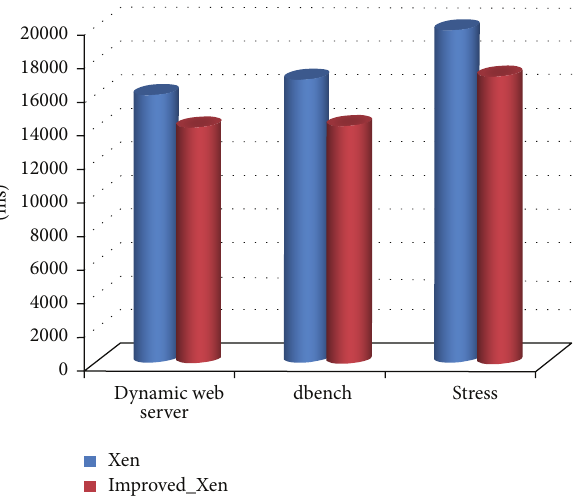
Figure 4: Comparison of dirty pages prediction using SVR model.